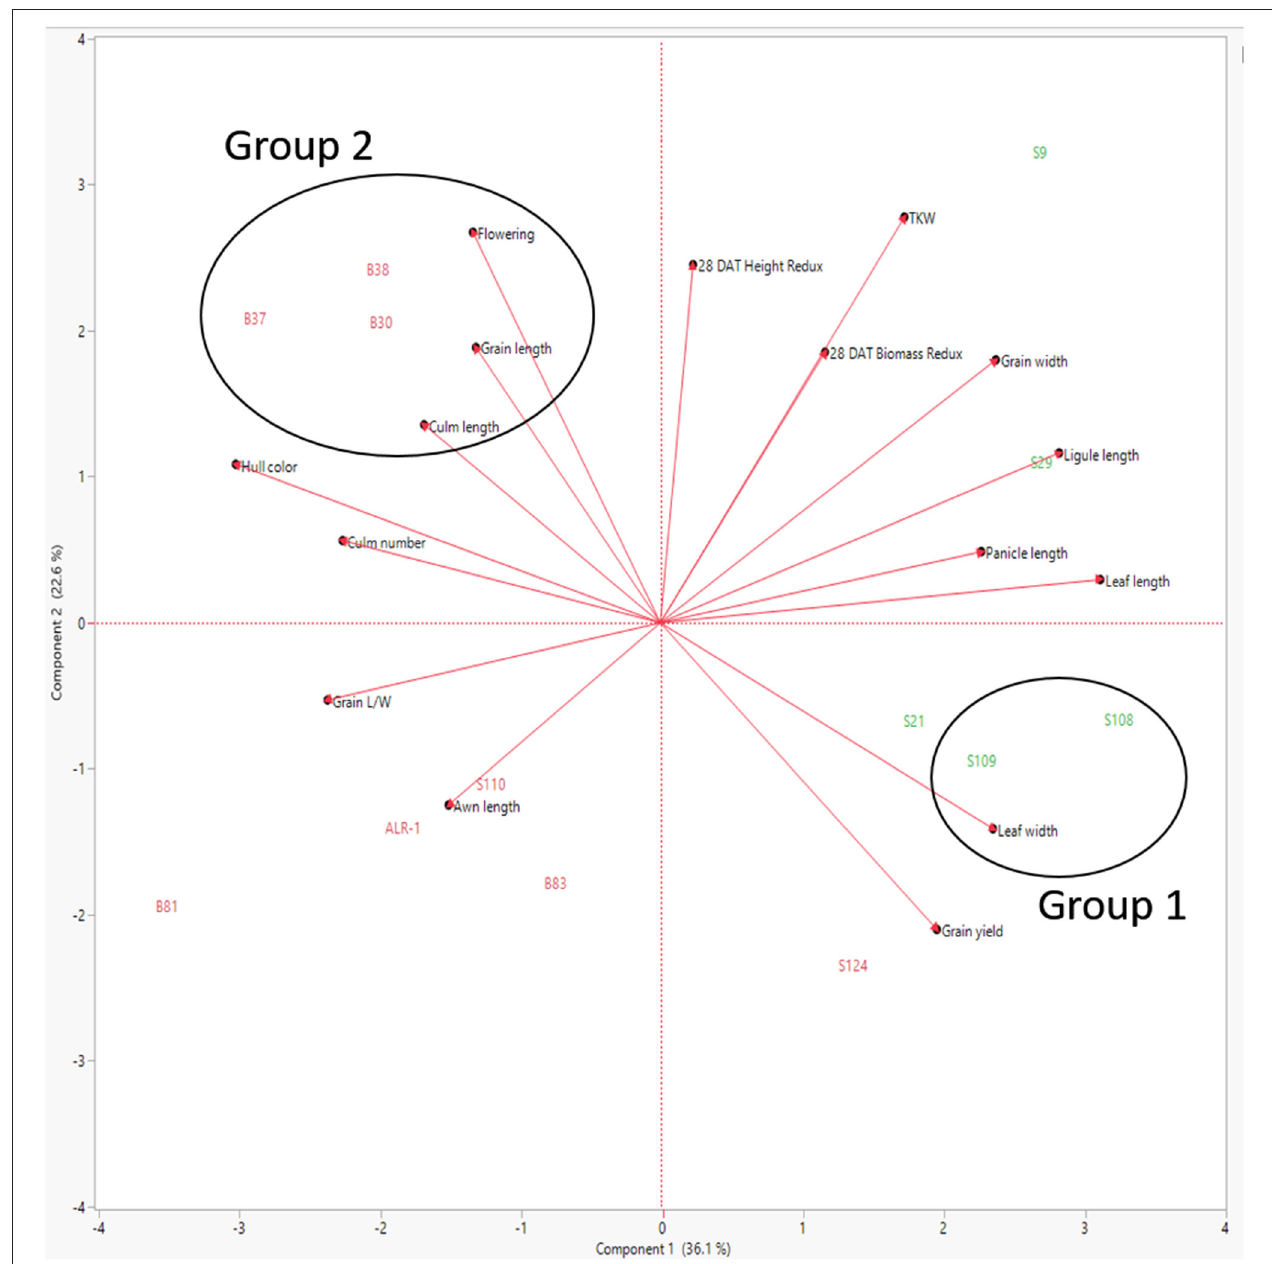
FIGURE 4 | Principal component analysis (PCA) of 16 agronomic traits, including plant height reduction and plant biomass reduction 28 days after heat stress treatment.